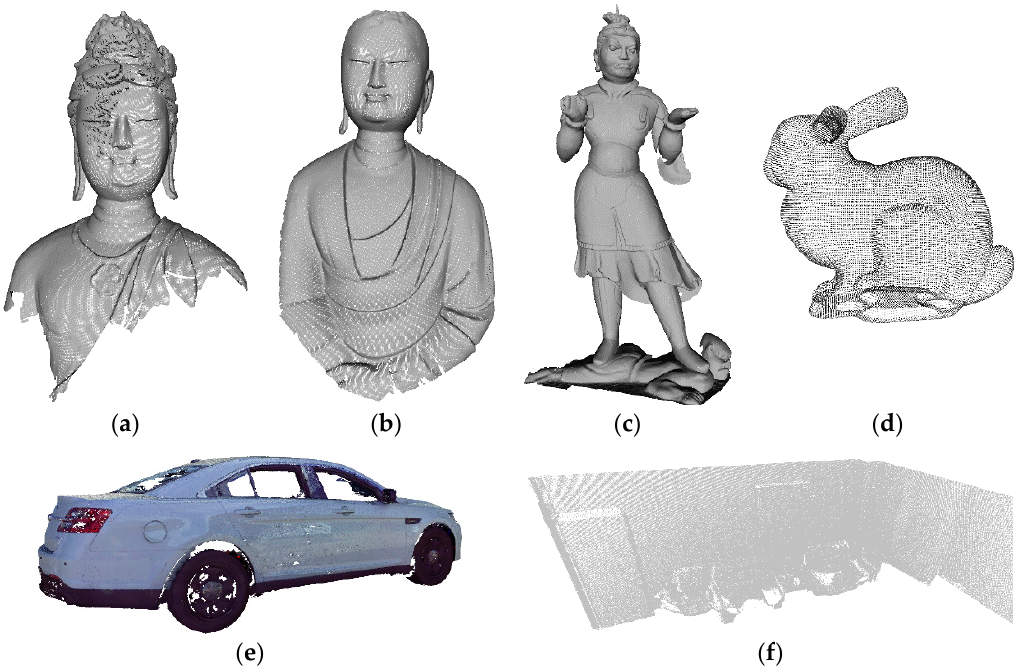
Figure 1. The point clouds from MoGao grottoes and Bologna dataset: ( a ) Bodhisattva model, ( b ) Ananda model, ( c ) general model, ( d ) rabbit model, ( e ) car model, and ( f ) indoor data. Table 2. Details of experimental datasets.